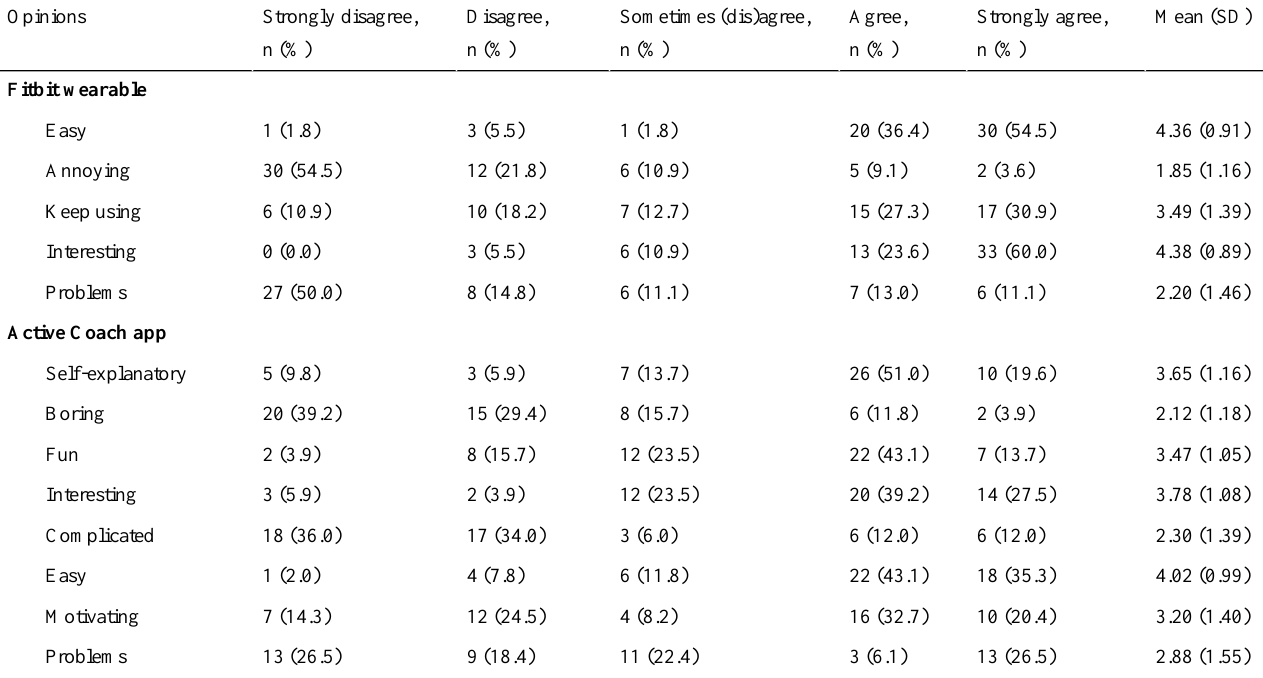
Mean (SD)Strongly agree,